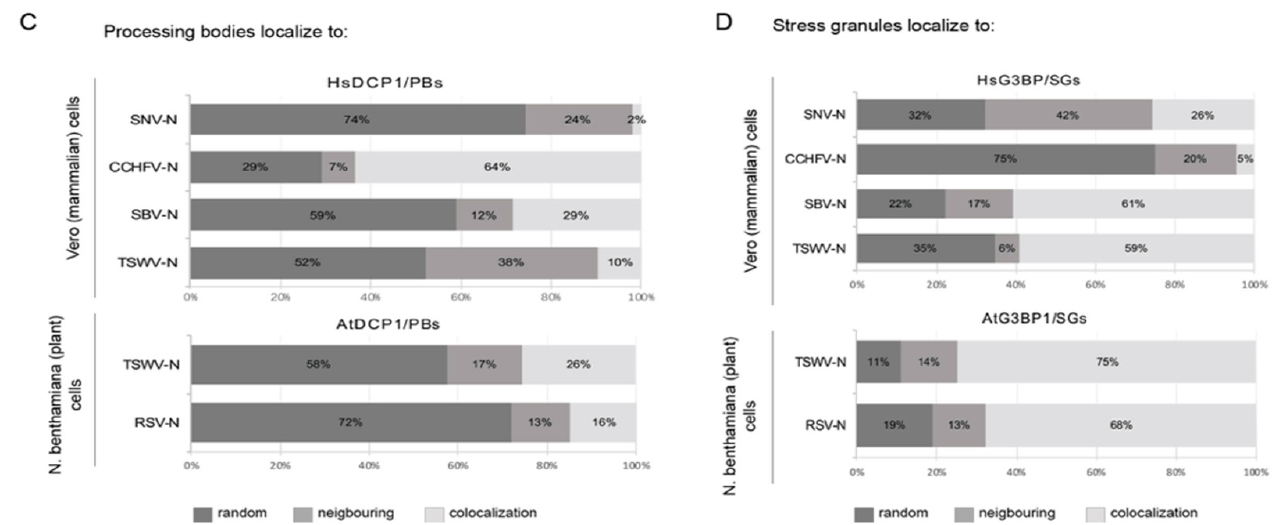
Figure 1. Localization and quantification of different NSV N proteins relative to PB/SG in plant cells and animal cells. ( A ) Fluorescence microscopy images of SNV, CCHFV, SBV and TSWV N-GFP protein localization relative to P body marker protein HsDcp1-mRFP (left panel) in Vero cells, and of RSV and TSWV N-GFP protein localization relative to P body marker protein AtDcp1-mRFP in plant cells (right panel). ( B ) Fluorescence microscopy images of SNV, CCHFV, SBV and TSWV N-GFP protein localization relative to SG marker protein HsG3BP1-mRFP (left panel) in Vero cells (subjected to arsenite treatment for SG-induction), and of RSV and TSWV N-GFP protein localiza- tion relative to SG marker protein AtG3BP1-mRFP in plant cells (subjected to a heat shock for SG- induction). ( C ) Quantification of P body localization relative to different N proteins. Colocalization, neighboring and random localization ratio were quantified for SNV, CCHFV, SBV and TSWV N protein in animal cells, and TSWV and RSV N protein in plant cells. ( D ) Quantification of SG local- ization relative to different N proteins. Colocalization, neighboring and random localization ratio were quantified for SNV, CCHFV, SBV and TSWV N protein in animal cells, and TSWV and RSV N protein in plant cells, after cells were treated for SG-induction. Bar is 10 µm.